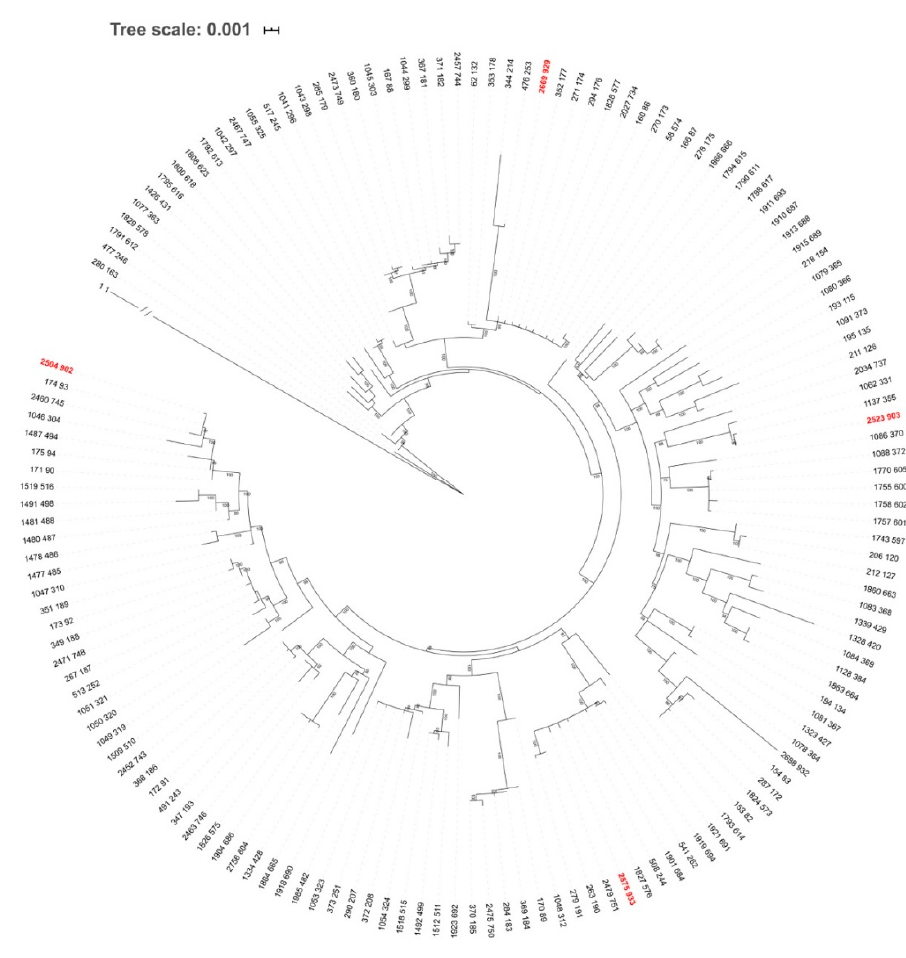
Figure 6. Unrooted ML tree of Borrelia garinii based on concatenated sequences of eight MLST genes. The tree involves sequences for 147 B. garinii sequence types (STs) deposited in the PubMLST database. Even though the tree is unrooted, B. burgdorferi s.s. (ST 1) was used as outgroup and was drawn at root. Branch length for B. burgdorferi s.s. is not scaled as indicated by the slashes. ML tree was constructed using IQ-TREE, based on the best-fit substitution model (GTR-F-R5) selected according to ModelFinder. The branch support was assessed using the aBayes test and is shown for branches with > 70% support. Taxon labels are isolate and ST IDs according to the PubMLST database. STs detected for the first time in this study are marked in red.